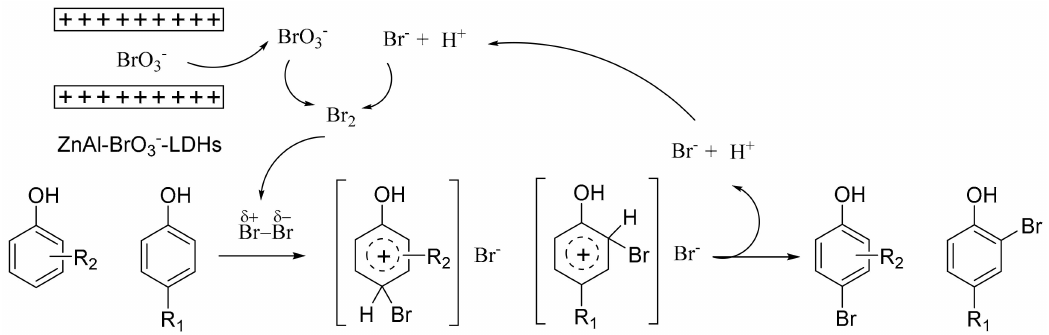
Figure 3. Proposed mechanism of